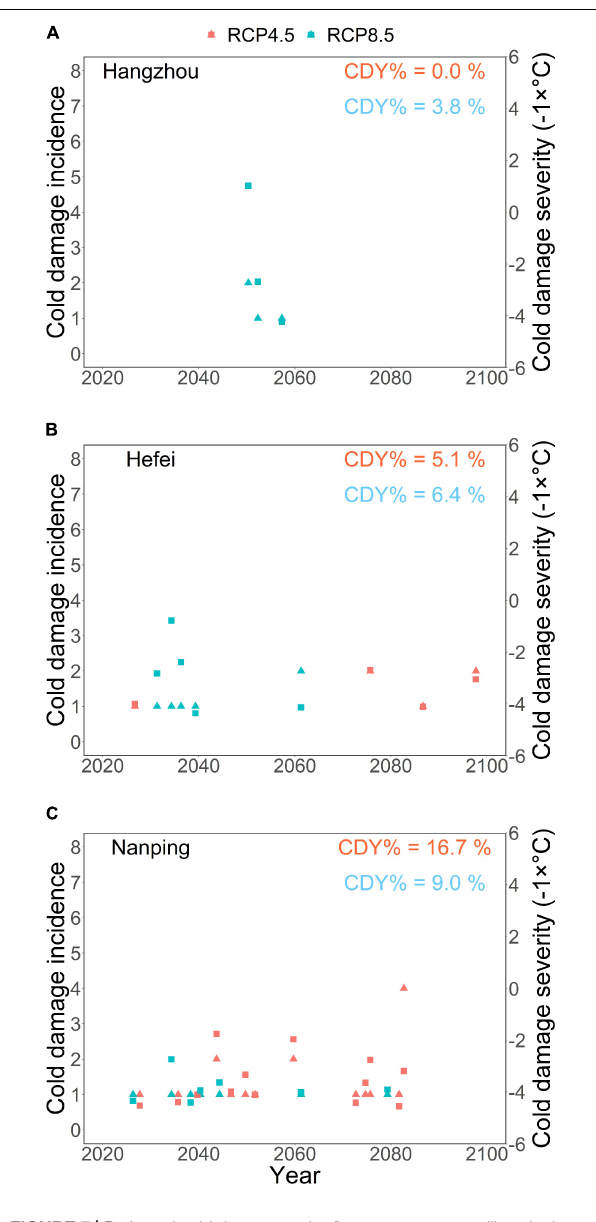
FIGURE 7 | Projected cold damage to the first-year pecan seedlings in three locations in subtropical southeastern China from 2021 to 2099 under the warming scenarios RCP4.5 (red symbols) and RCP8.5 (blue symbols). (A) Hangzhou and (B) Hefei are located in the main pecan cultivation area in the northern part of the subtropical monsoon climate zone and (C) Nanping south of the main pecan cultivation area. The cold damage was projected by examining whether the air temperature dropped below the threshold of +5 ◦ C during the time window from 10 days before the projected leaf-out ( Figure 6 ) to May 31. If cold damage was projected for a given year, it was quantified by its incidence (number of days when damaging air temperatures occurred: triangles, vertical axis on the left-hand side), and severity (the lowest temperature that occurred during those days: squares, vertical axis on the right-hand side). In order to make both cold damage indices increase from the bottom to the top of the panels, the severity is expressed by the opposite number of the corresponding temperature. The values of CDY% in red and blue indicate the percentage of cold damage years for the respective warming scenarios out of the 79 years